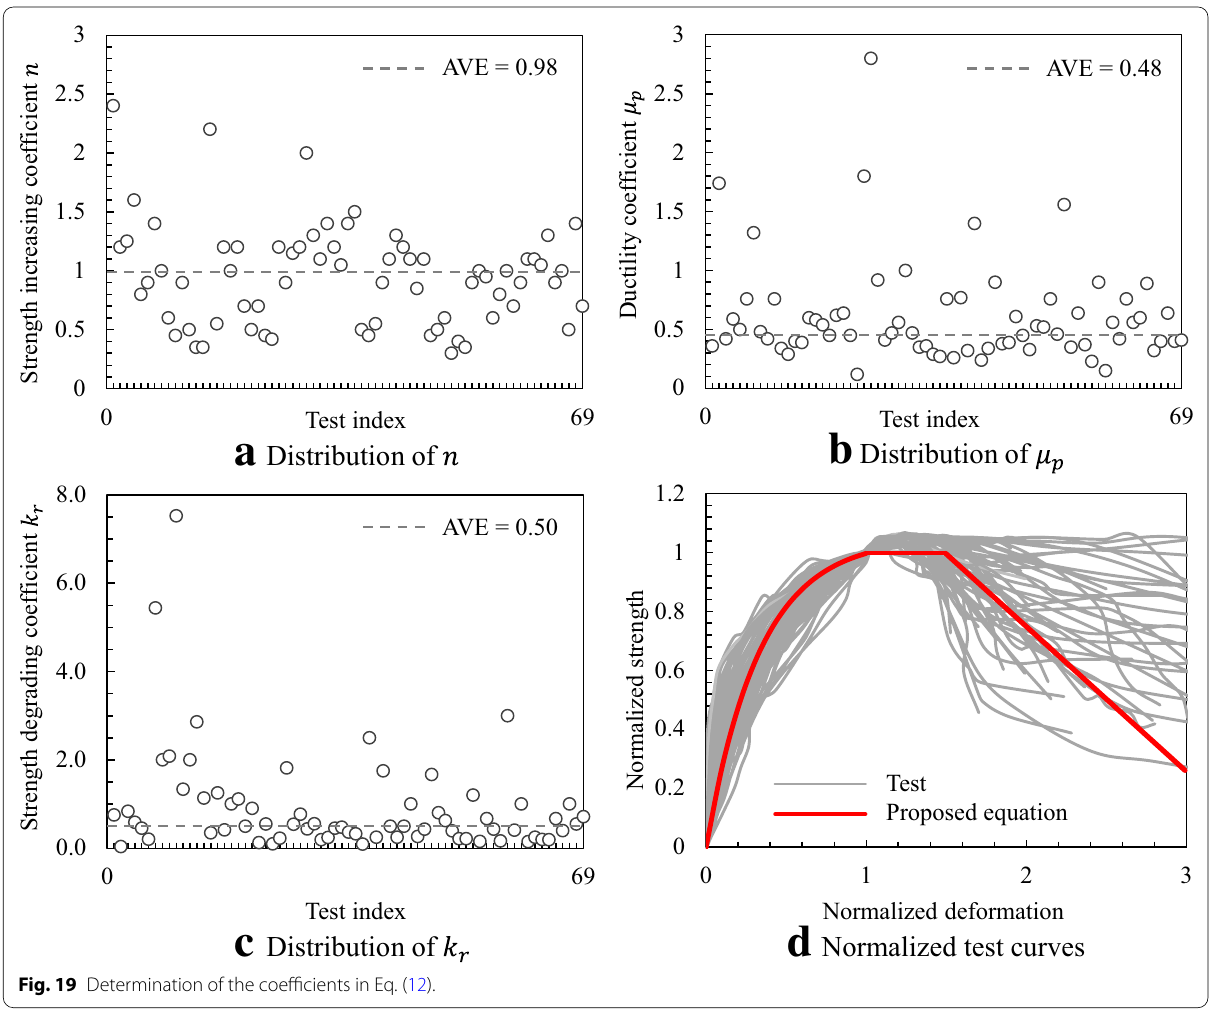
Fig. 19 Determination of the coefficients in Eq.